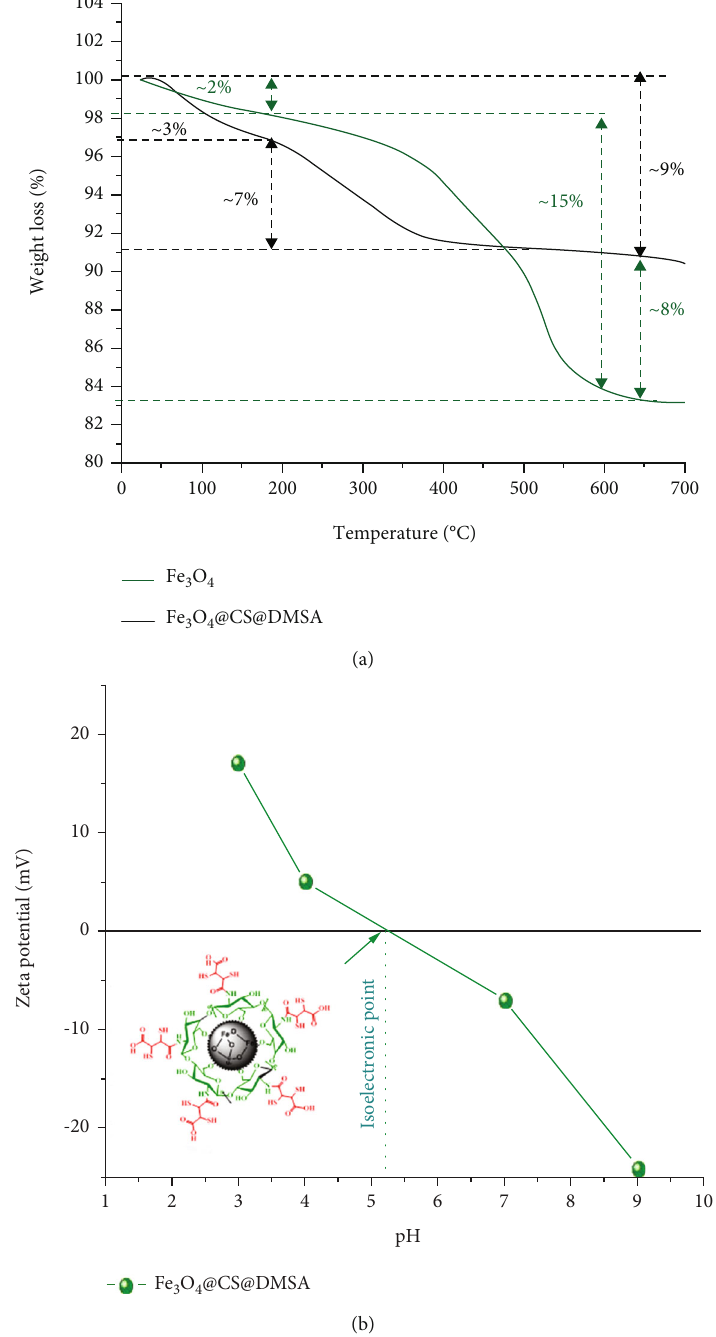
Figure 2: TGA analysis of (a) Fe